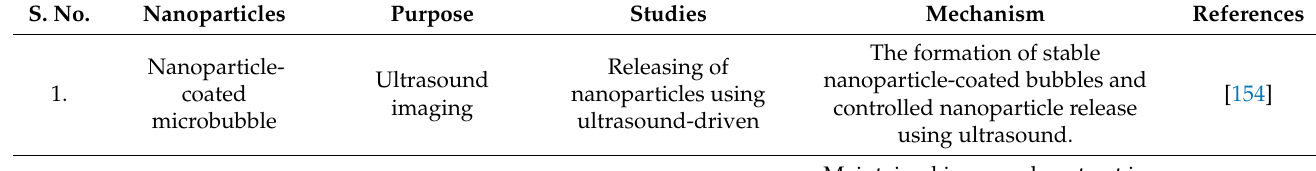
Table 4. Nanoparticles in molecular imaging/medical